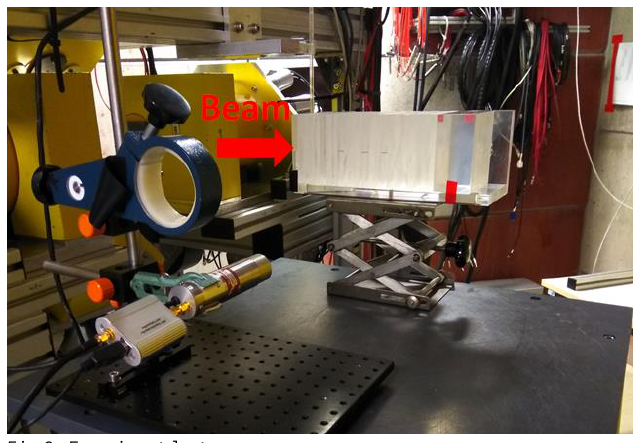
Fig. 2. Experimental